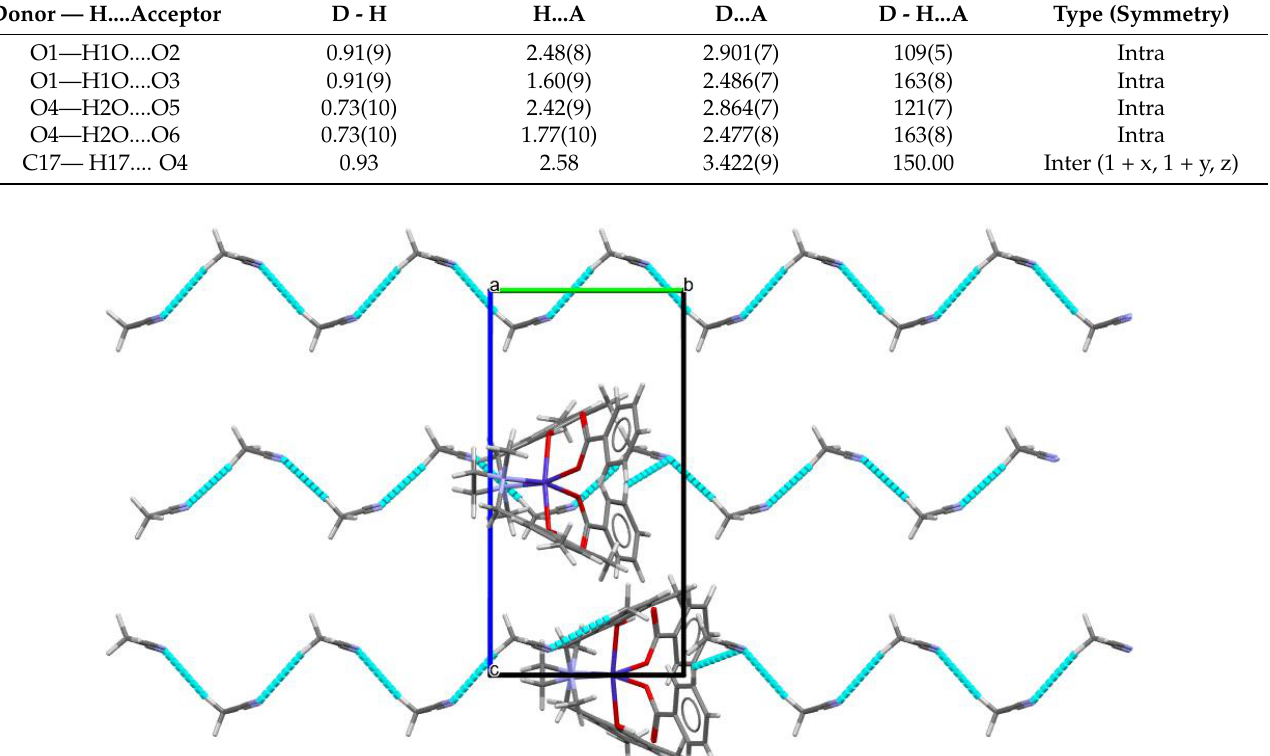
Figure 4. The solvent, acetonitrile, forms 1-D zig-zag chain along b- axis, as shown by blue dashed line. Table 1. Hydrogen-bonding geometries (Å and °) for 1 .